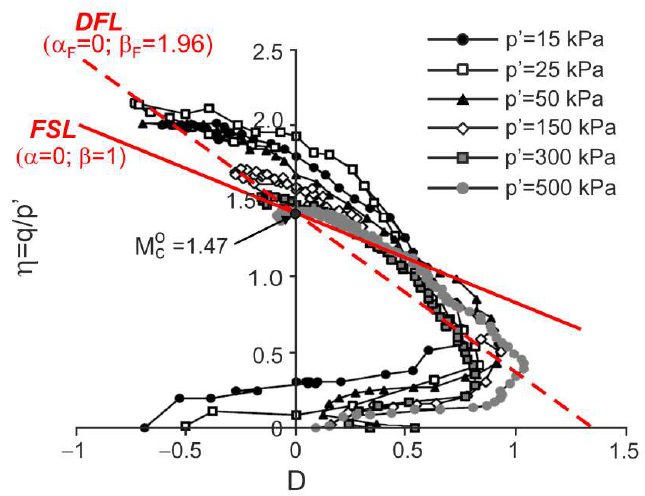
Figure 12. Stress ratio–dilatancy relationships for the drained triaxial compression of natural granitic residual soil (adapted from [7]). Reprinted from Publication Proceedings of the 15th European Conference on Soil Mechanics and Geotechnical Engineering, Part 2, Cruz, N.; Viana da Fonseca, A.; Rodrigues, C., The influence of microfabrics in bonded soils behaviour, based in laboratorial comparison of artificially and naturally cemented specimens, 173-178, Copyright (2022), with permission from IOS Press. The publication is available at IOS Press through http: